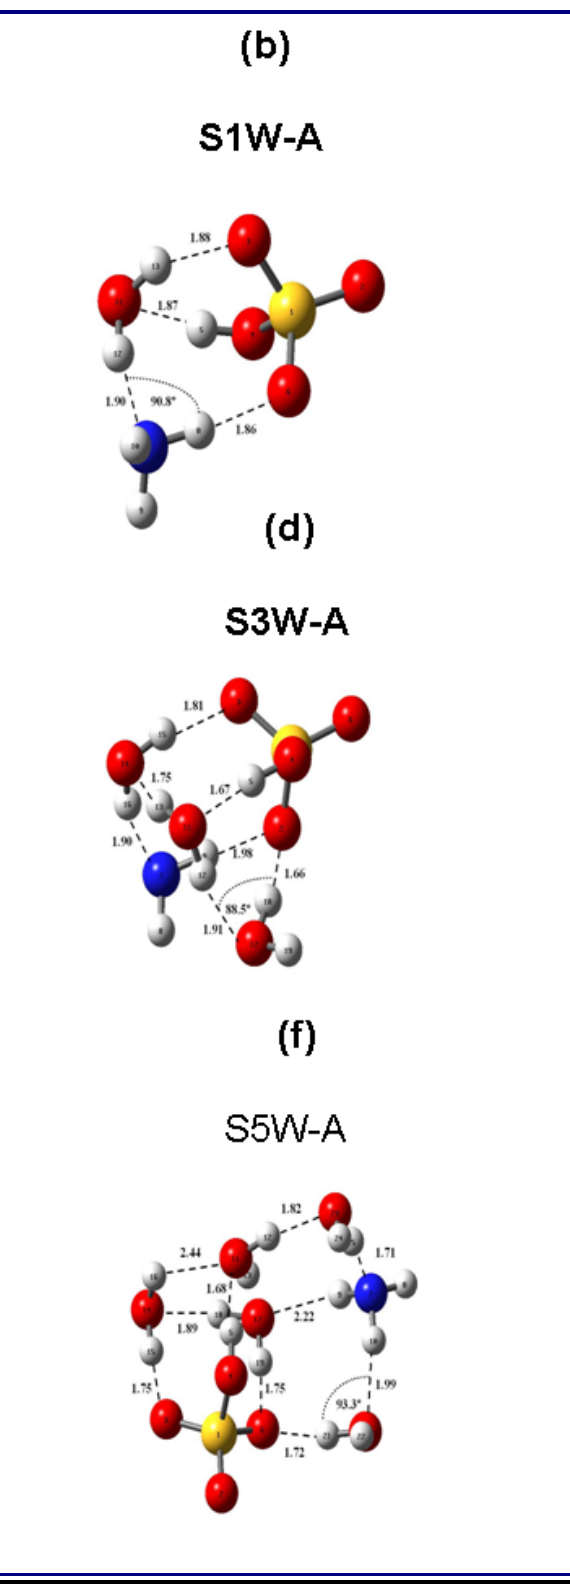
)(H O) ; (d) (HSO 4- )(NH 3 2 2 )(H O) obtained at PW91PW91/6-311++G(3df,3pd) level of 3 2 5